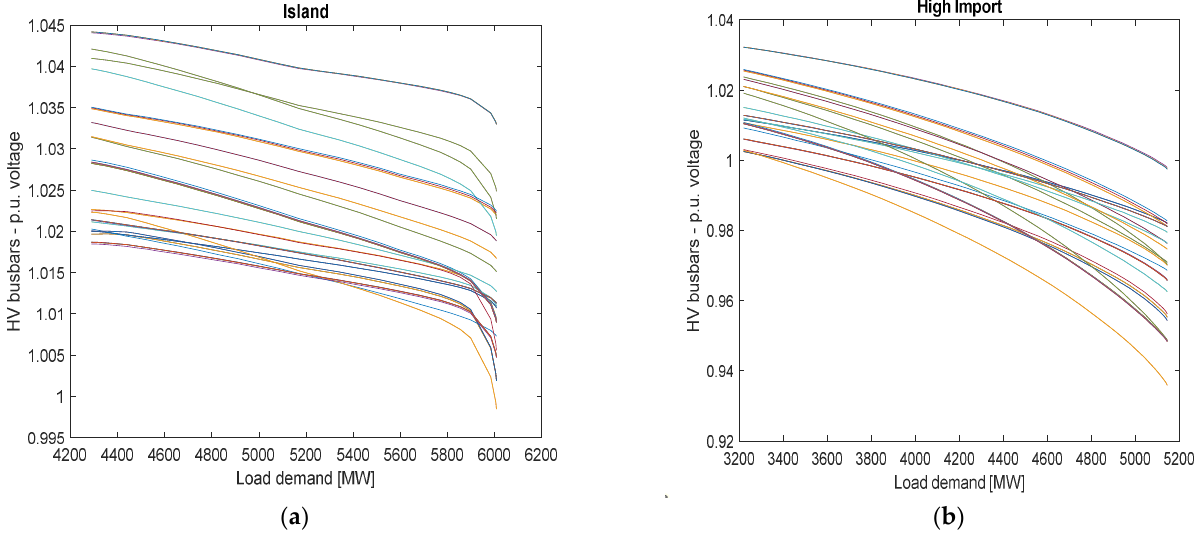
Figure 18. HV voltage profile of the Island DP ( a ), HV voltage profile of the High Import DP ( b ).